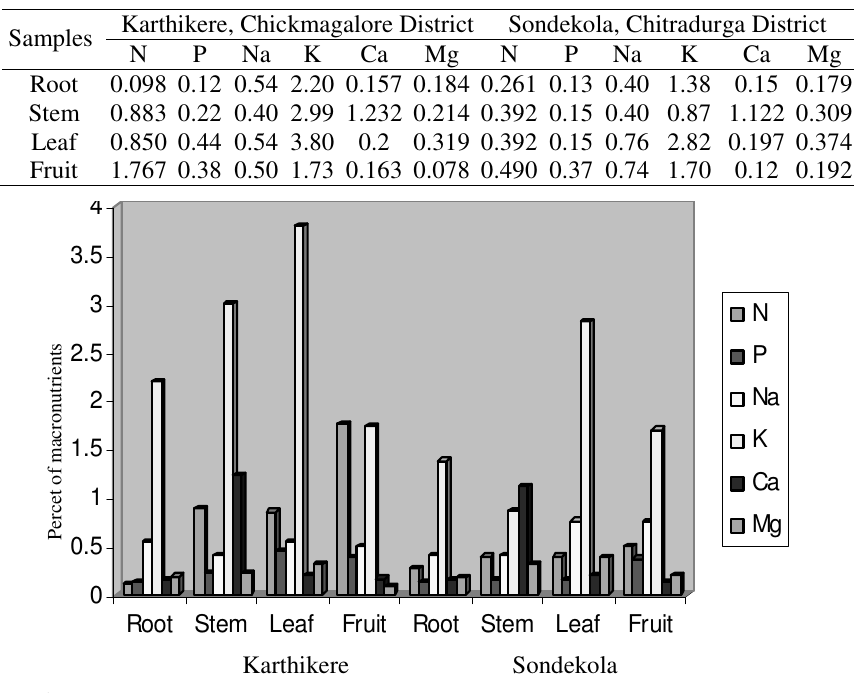
Figure 2. Variation of macro elements of the root, steam, leaf and fruit samples of Withania somnifera (Linn.) Dunal at Karthikere and Sondekola of Karnataka,